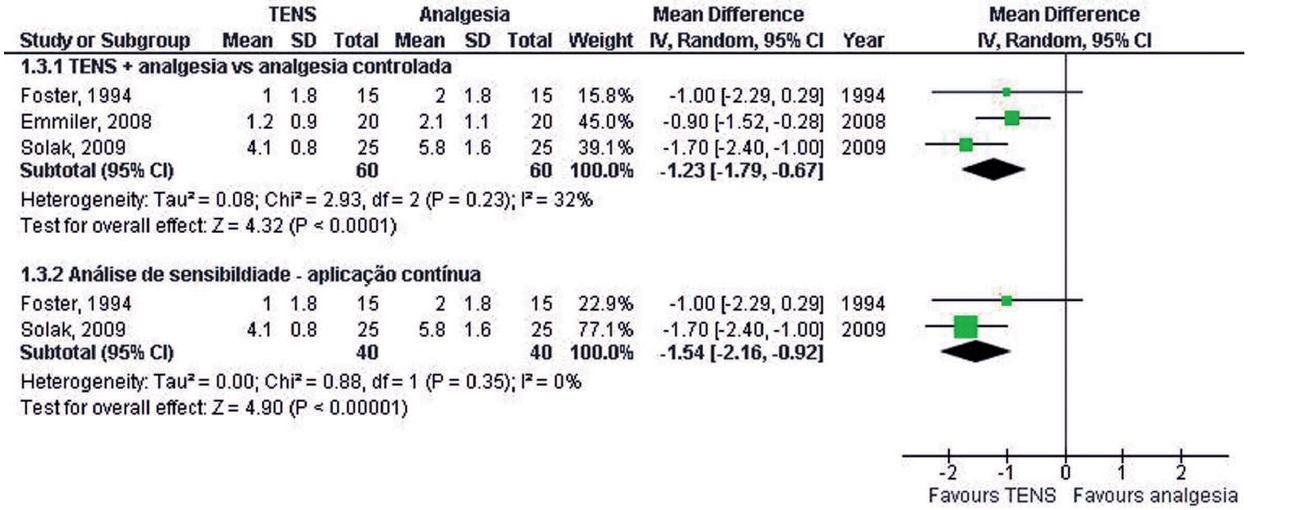
Fig. 4 – Análise da dor referente aos estudos que realizaram cirurgia com abordagem por esternotomia mediana: comparação da TENS + analgesia farmacológica vs. analgesia farmacológica controlada. TENS – estimulação elétrica nervosa